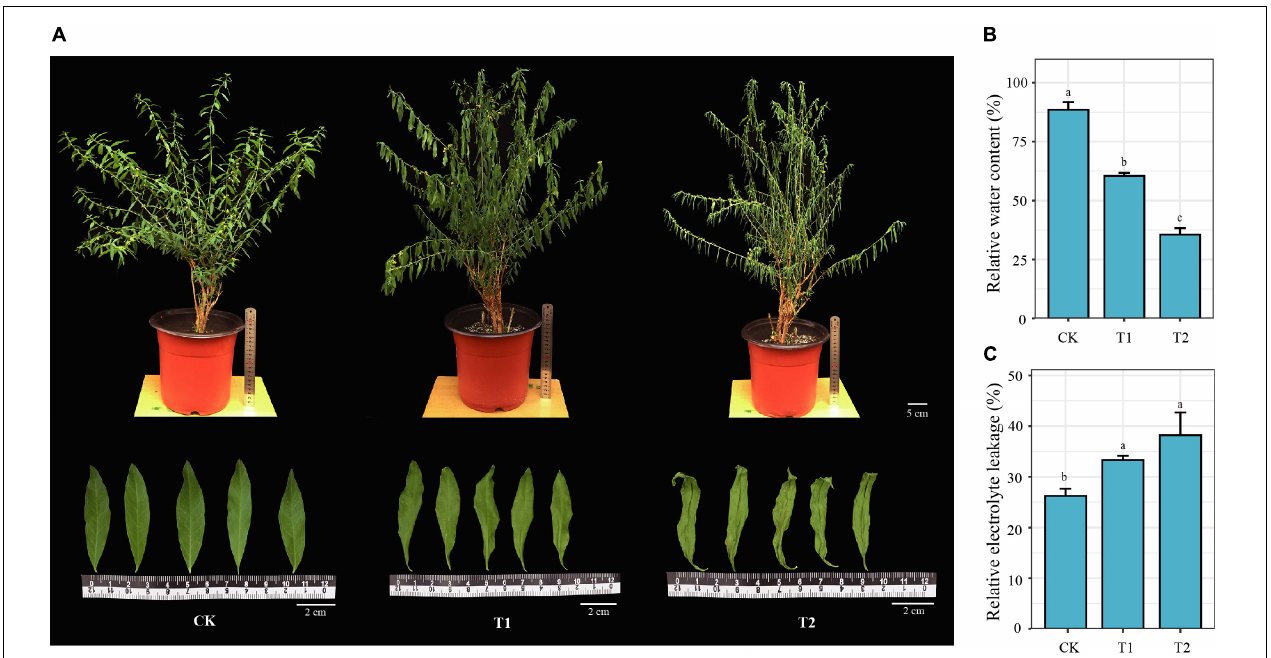
FIGURE 1 | Phenotypic and physiological responses of Heimia myrtifolia . (A) Morphological observation of H. myrtifolia in response to different drought stress treatments. (B) Relative water content (%). (C) Relative electrolyte leakage (%). Different letters indicate the result is significantly different ( p < 0.05).